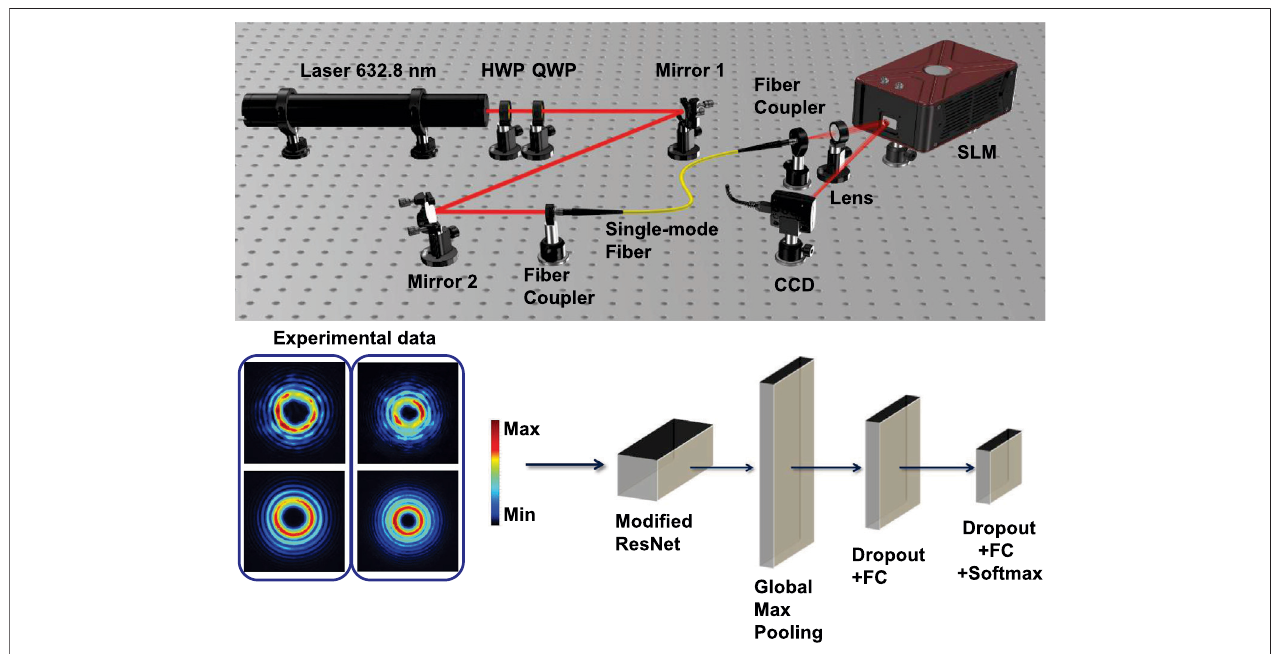
FIGURE1| Theexperimentalsetup (upperpanel) and ourcustomized deep learning algorithm(lowerpanel). We perform theexperiment using acollimatedHe-Ne laser beam. The vortex beam is generated using an SLM with the computer-generated hologram. Finally, the intensity images are collected by a CCD and used for training and testing. Our deep learning network consists of the unaltered ResNet-101 bottom layer and our redesigned top layer.